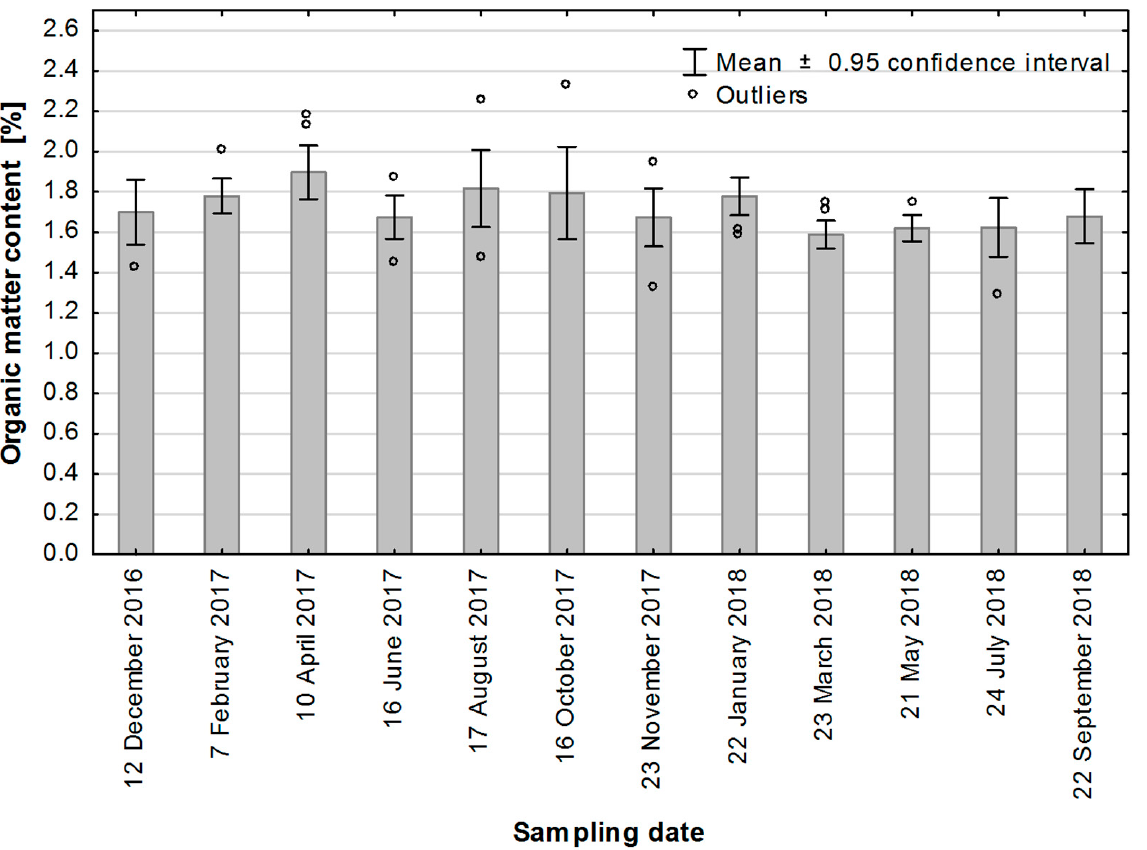
Figure A3. Amplification product of the nested real-time PCR with aligned Zur primers and probe [18,25].